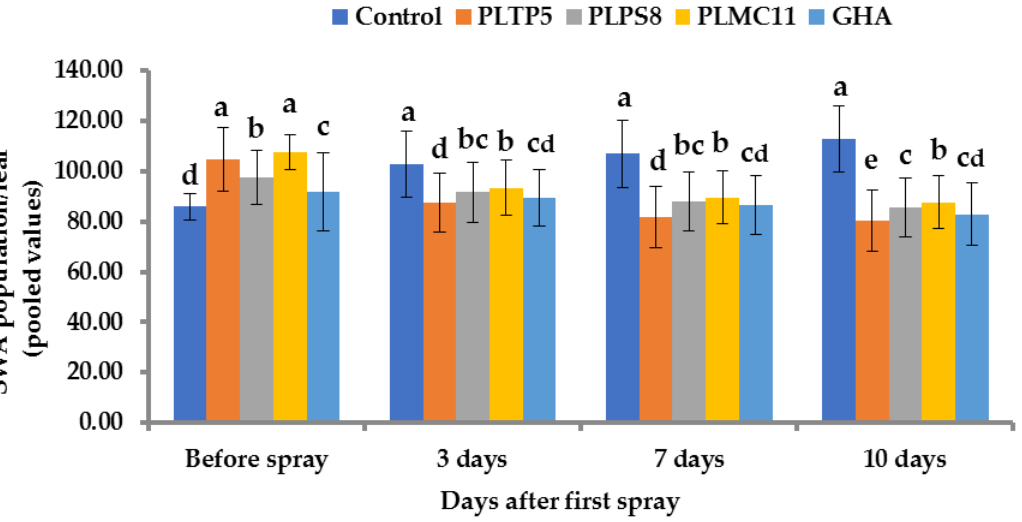
Figure 4. Population of C. lanigera per leave treated with 1 × 10 8 conidia mL − 1 of EPF isolates, recorded at different time intervals after first spray. Different letters (a–d) in columns indicate significant differences ( p ≤ 0.05) among the isolates. Columns represent the mean ± SD ( n = 3). SD = standard deviation.